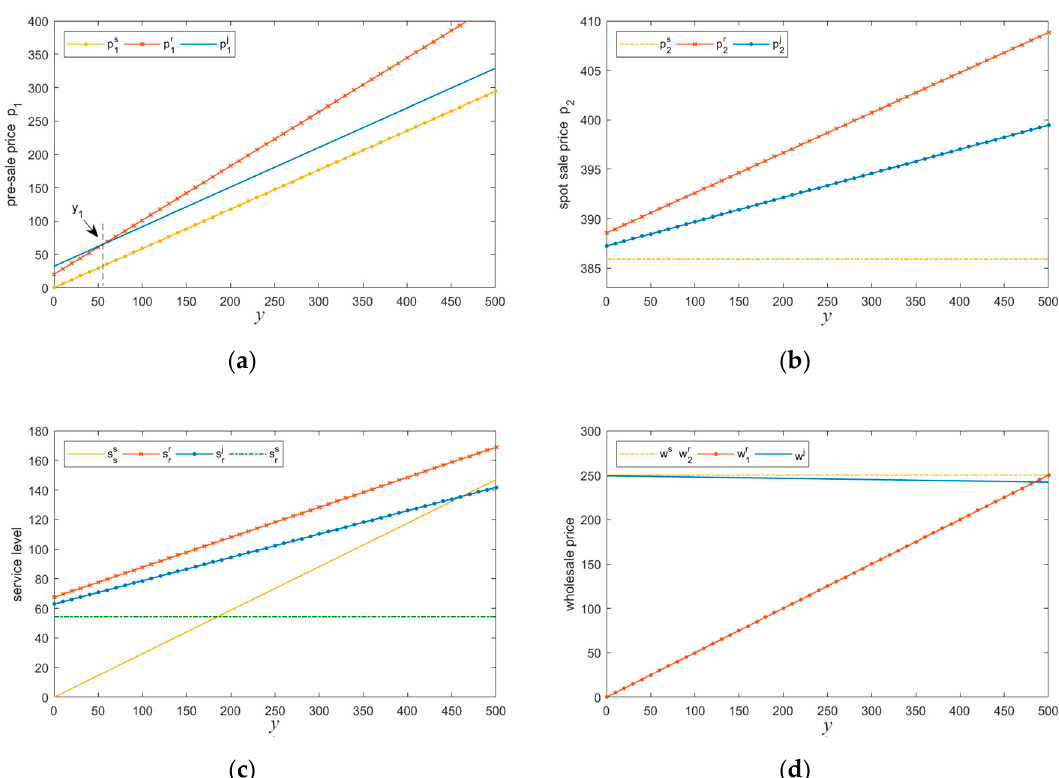
Figure 4. Optimal pre-sale price ( a ), spot sale price ( b ), service( c ) and wholesale price ( d ) with respect to y under the three strategies.